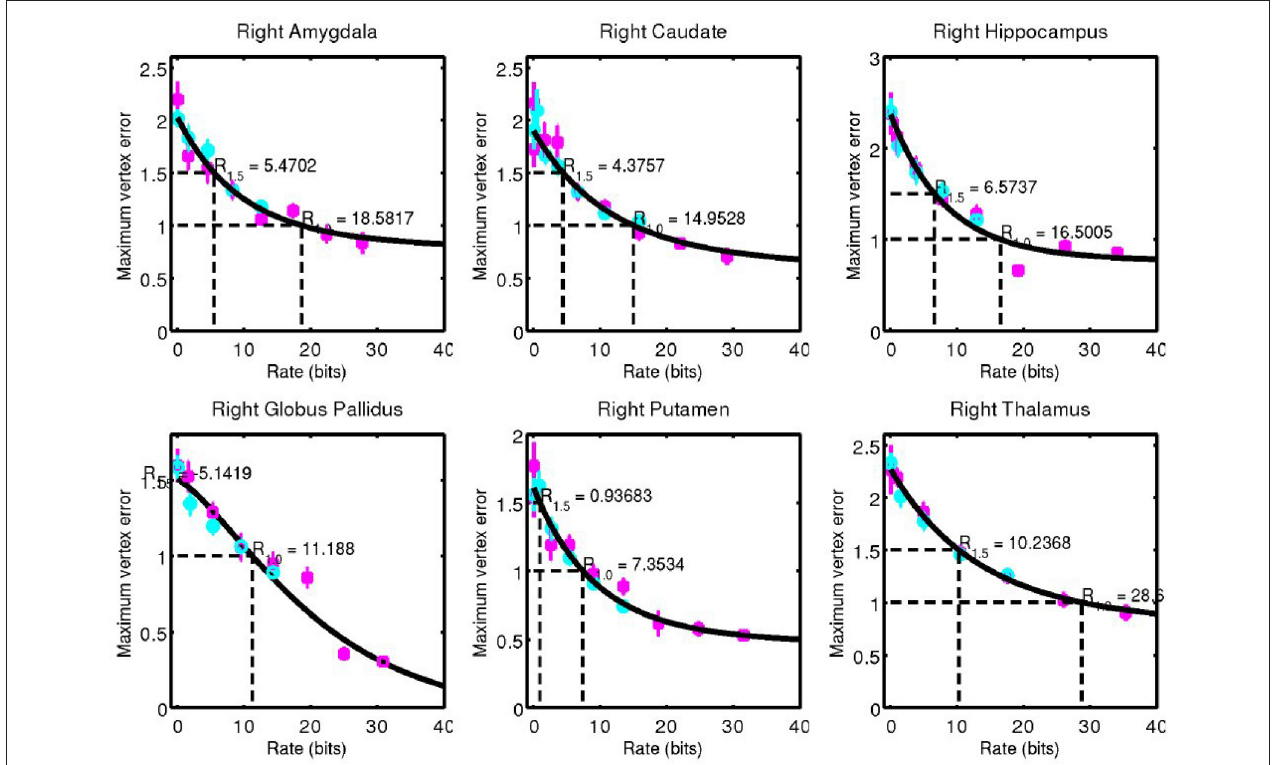
FIGURE 8 | Corresponding data from Figure 7 for right side